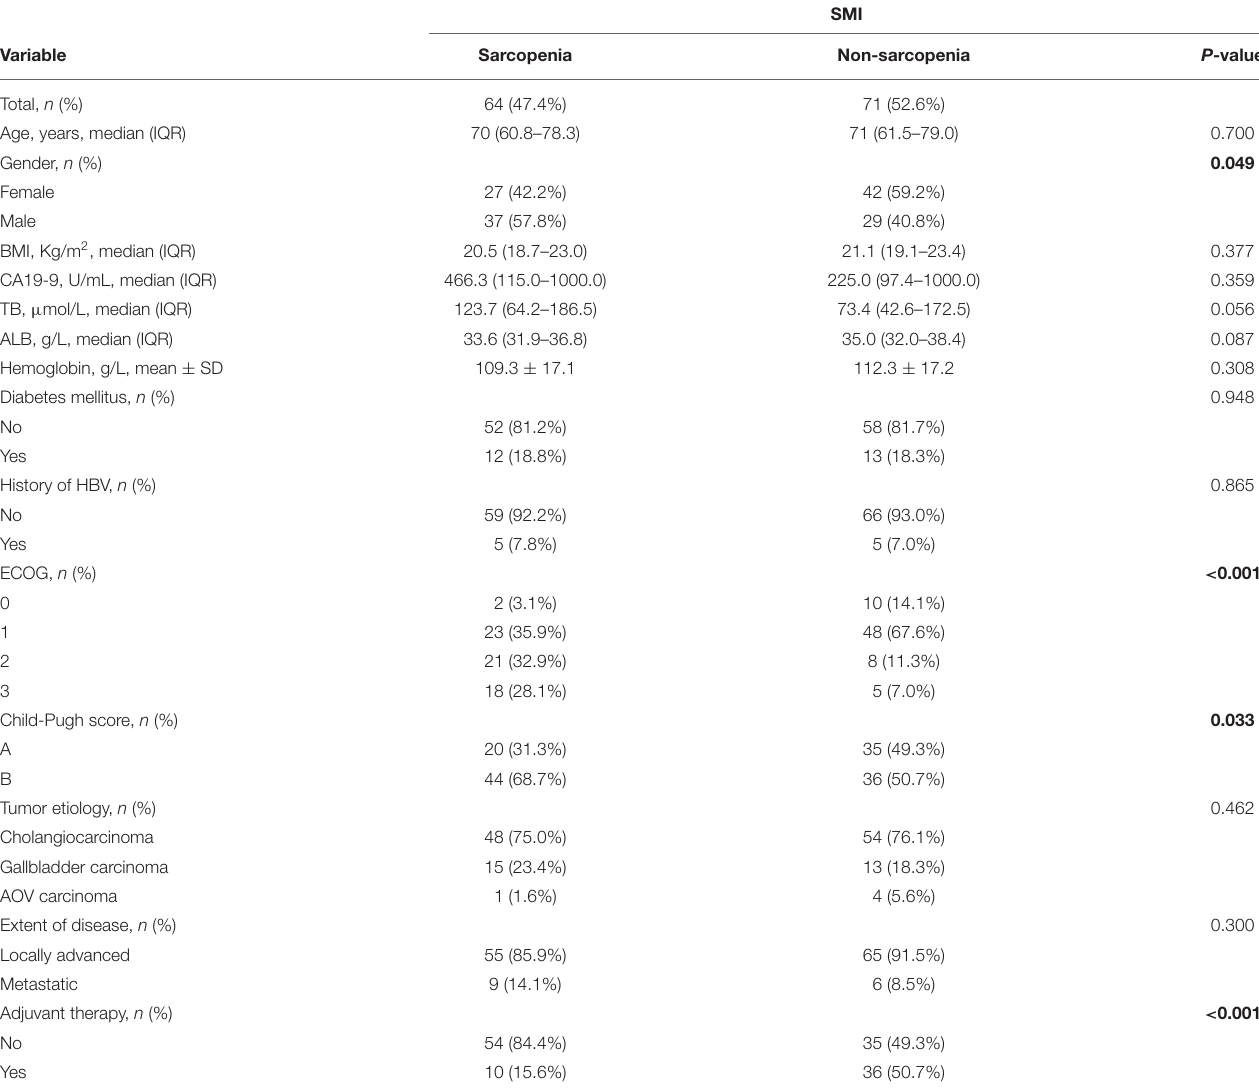
TABLE 2 | Comparison between sarcopenia and non-sarcopenia group when using SMI as an assessment tool.